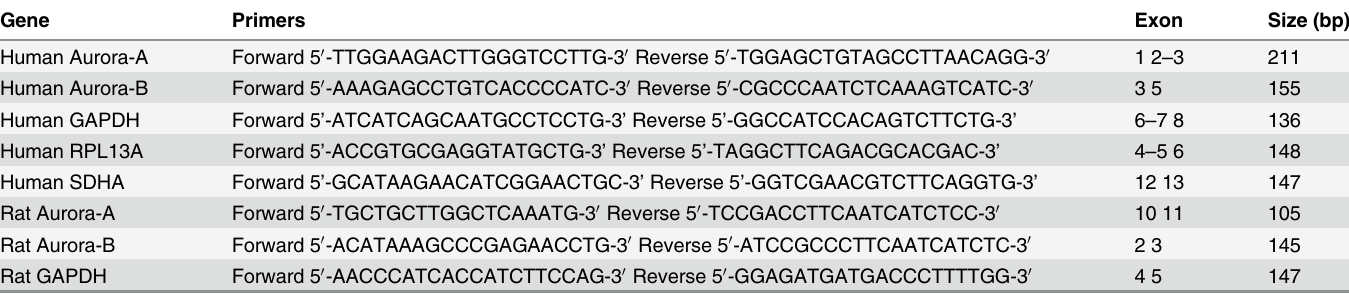
Table 1. Sequences, genomic positions, and amplicon sizes of the primers used in qRT-PCR for the target and reference genes.